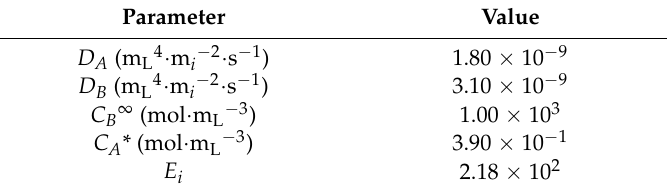
Table 2. Other parameters used in the simulations (based on properties of the system CO 2 /NaOH [6]).